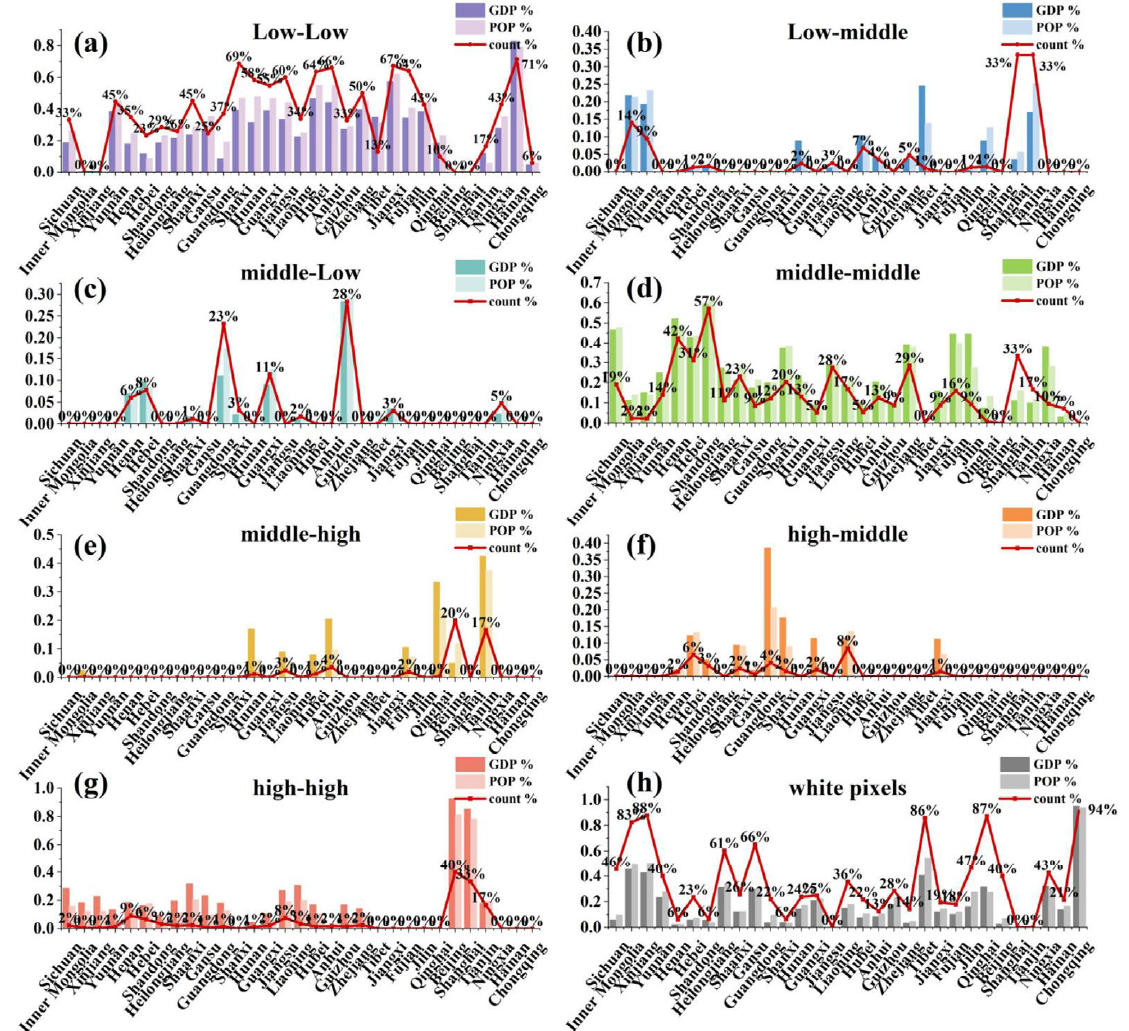
Figure 8. The proportions of the numbers of different types of grid cells in each province and the proportion of the GDP and population of those grid cells in each province.